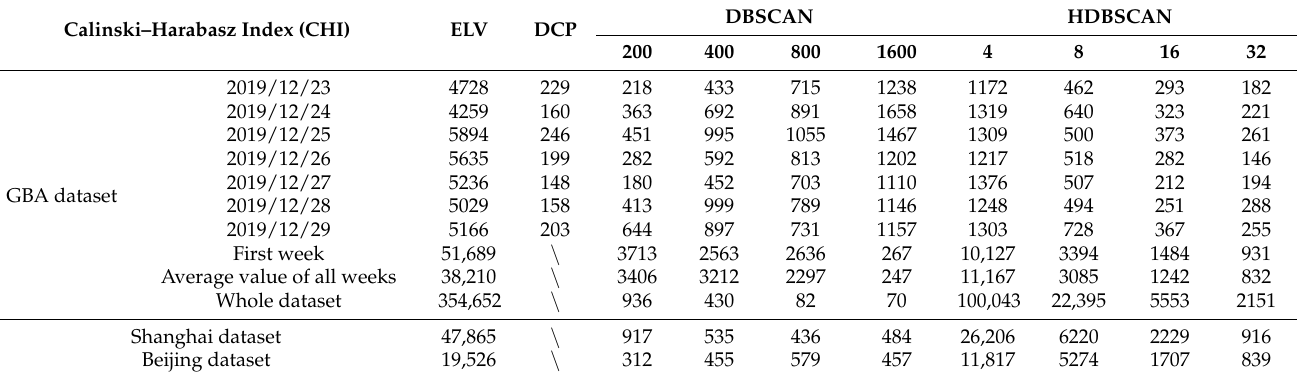
Table 5. Evaluation results of the different methods on the datasets based on